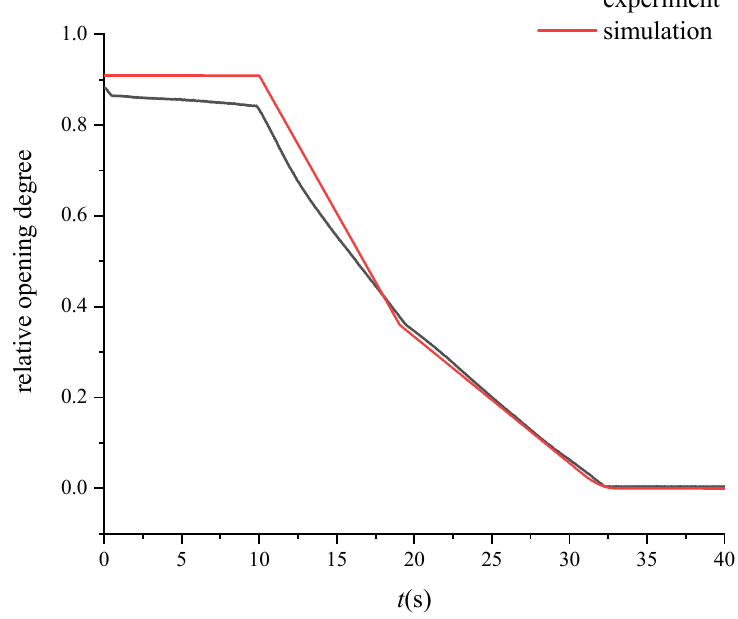
Figure 7. Comparison of the guide vane closing law.